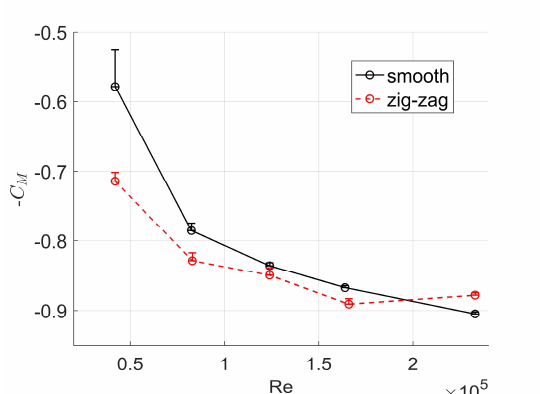
Figure 5. Negative normalized time-average streamwise momentum through the plane in the wake of the stretched leg dressed time-trial apparel ( black solid line ) and with zigzag tape ( red dashed line